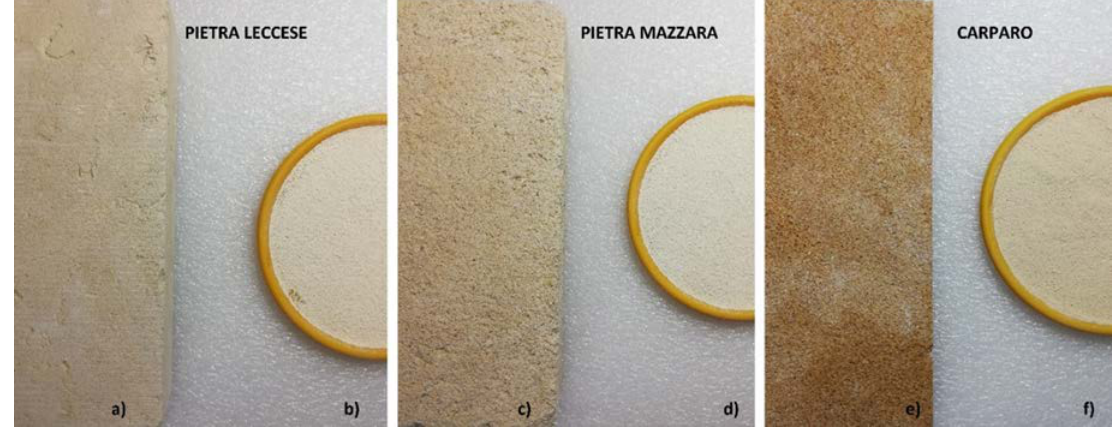
Figure 2. Picture of stones’ samples of Pietra Leccese ( a ), Pietra Mazzara ( c ) and Carparo ( e ) and respective powder ( b – f ).